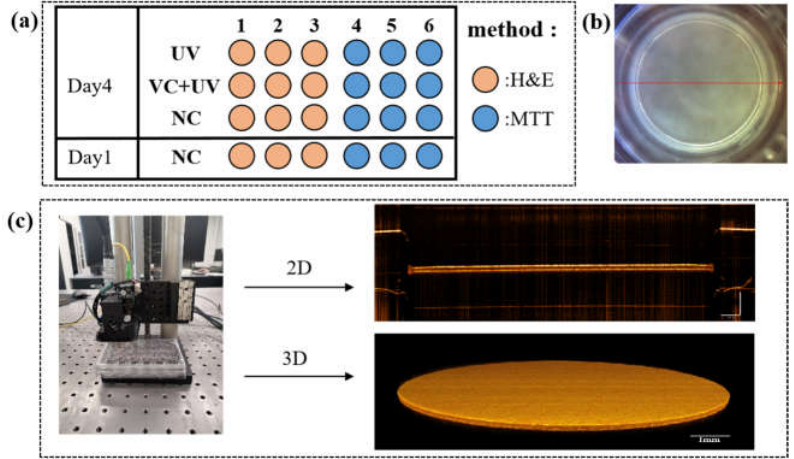
Figure 1. ( a ) Experimental groupings, MTT experiments, and H&E staining microscopic observation. UV—UVA irradiation group (Group 1); UV + VC—UVA irradiation group with medium VC (Group 2); NC—normal cultured AS (includes Group 3 and Group 4); ( b ) AS model images; ( c ) AS model for 2D and 3D OCT data acquisition.